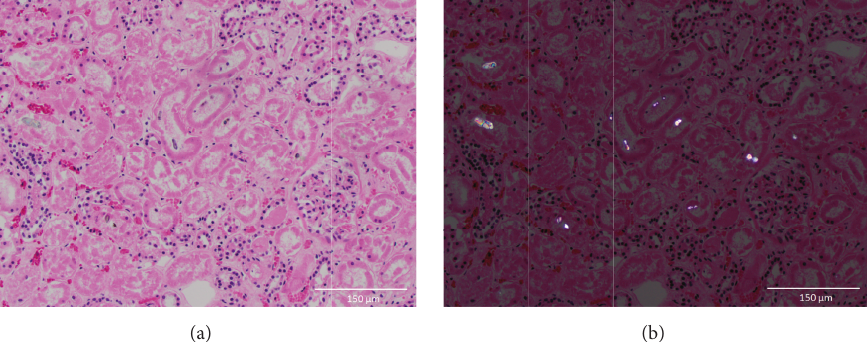
Figure 1: Histologic examination of the kidney revealing calcium oxalate crystals which appear birefringent under polarized light (b).